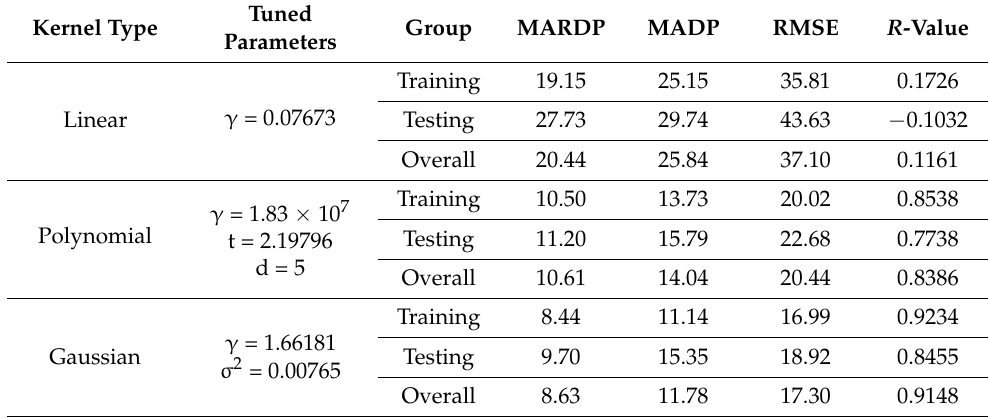
Table 2. The best results obtained by LS-SVRs with different kernel types (leave-one-out CV and 10-fold